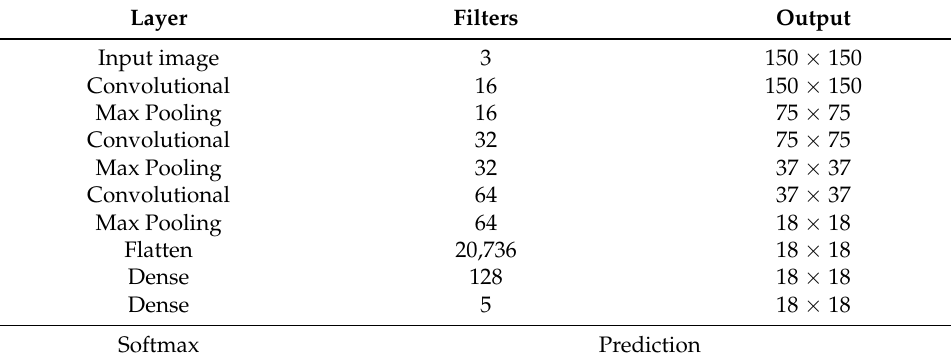
Figure 5. Image Classification model. Table 2. CNN model